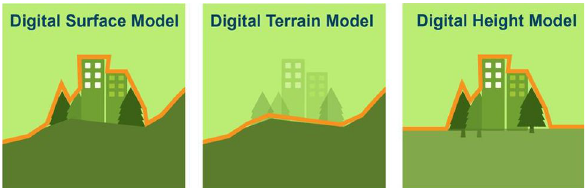
Figure 2. Digital Height Model (source Intermap on Twitter)